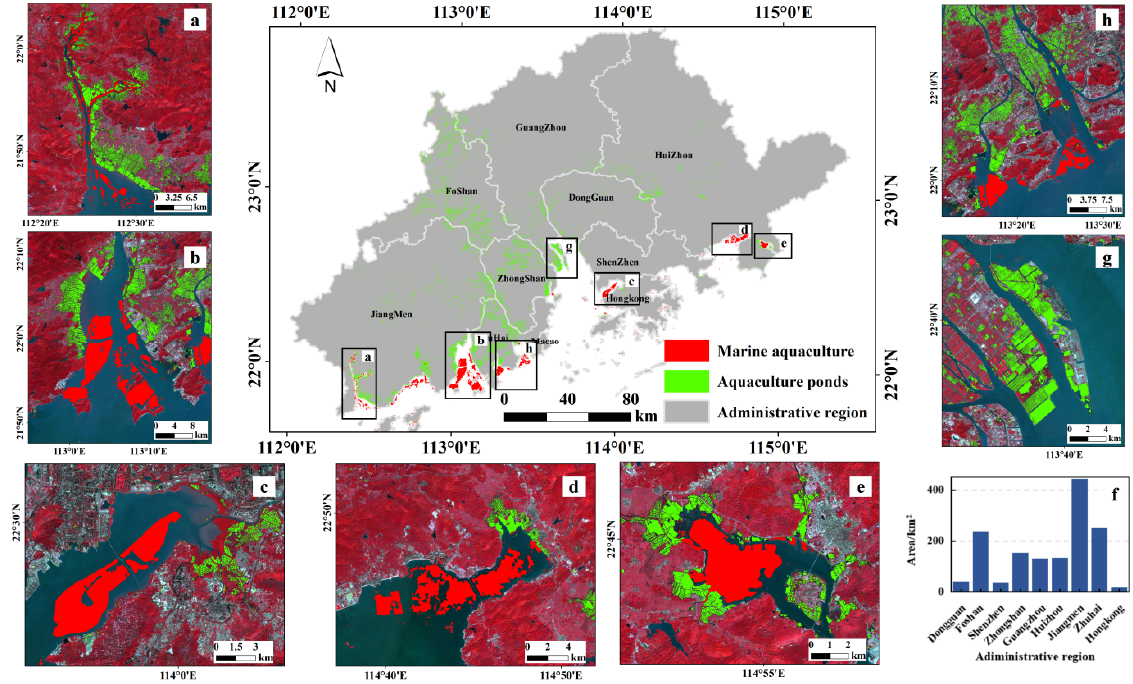
Figure 11. Aquaculture maps in the Pearl River Basin (Guangdong) in 2020: ( a ) Zhenhai Bay, ( b )Yamen watercourse, ( c ) Shenzhen Bay, ( d ) Baisha Bay, ( e ) Baisha lake, ( f ) Histogram of aquaculture area in major administrative regions, ( g ) Pearl River Estuary, and ( h ) Niwanmen watercourse.